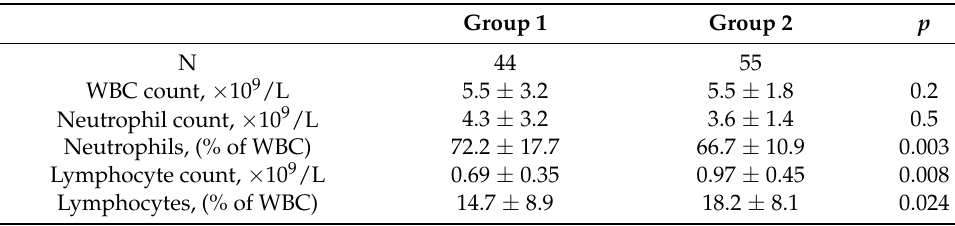
Figure 1. Comparisons of inflammatory parameters between hemodialysis patients affected by COVID-19 during the first pandemic waves of 2020 and last wave of 2021–early 2022. Normally distributed data are expressed as means with 95%CI in ( A , C ), while nonnormally distributed data are expressed as medians with 95%CI in ( B , D ). * p < 0.01. Group 1, from March to December 2020 (red lines); Group 2, from September 2021 to February 2022 (green lines). Table 3. Basal laboratory parameters of hemodialysis patients affected by COVID-19 during the different periods